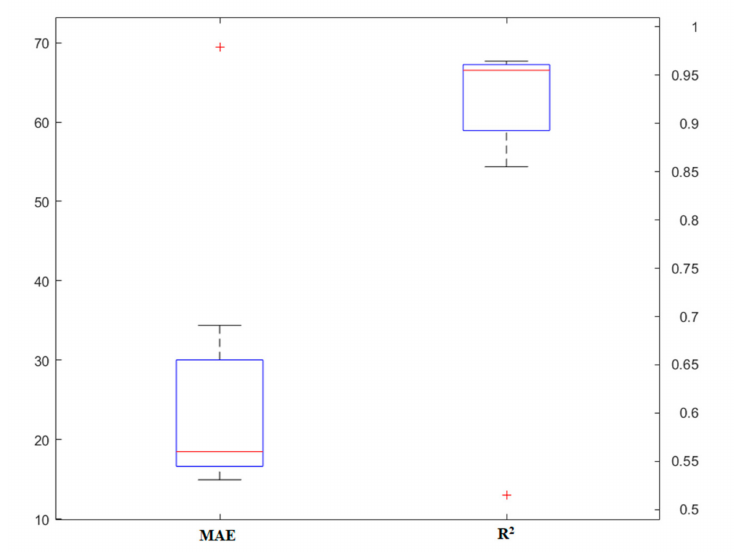
Figure 8. The results of the RT model, based on the tree